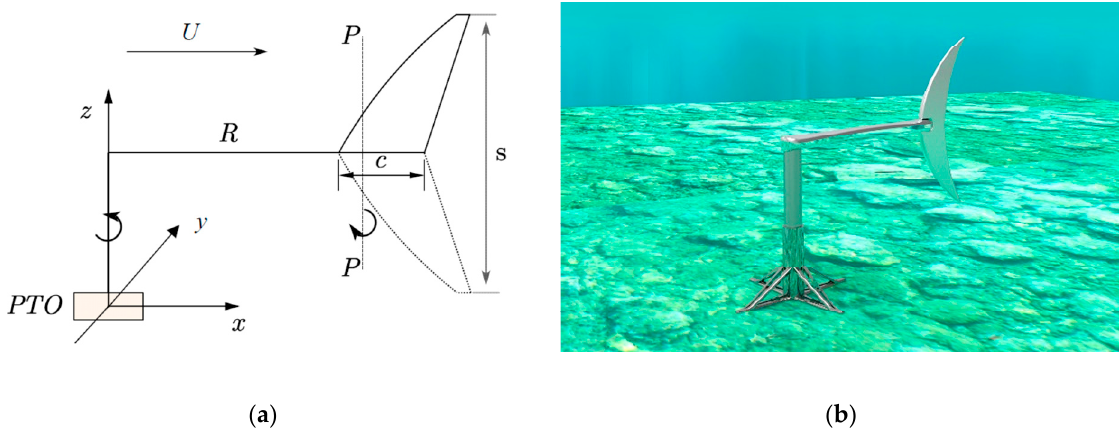
Figure 1. ( a ) The studied flapping-foil, biomimetic flow energy harvester. ( b ) Indicative 3D view of the device.